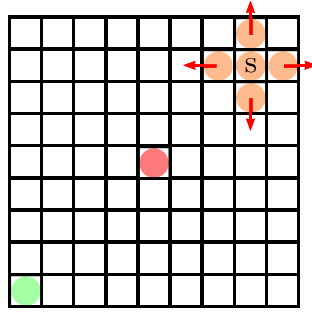
Figure 3. Schematic for the perturbed random walk on a lattice. Here a random walk starting at the bottom left corner (green dot) will wander through the lattice until the target (red dot at the center) is reached. At some cells s , the transition probabilities of the cell neighbors are perturbed (orange dots